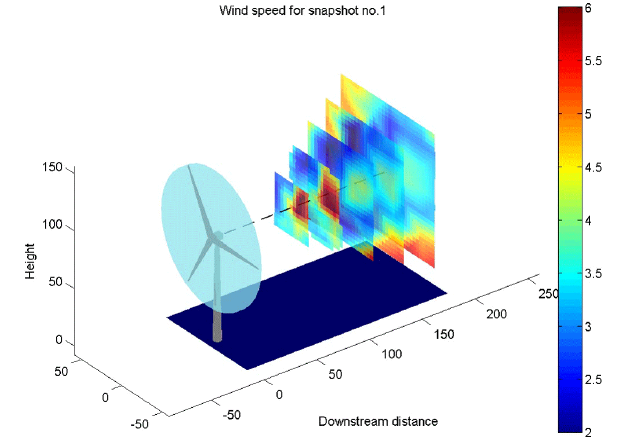
Figure 5. Example of snapshot taken with a nacelle-based lidar scanner. Measurement taken over ≈ 9s. The colour map represents the line-of-sight wind speed in [ms − 1 ] interpolated into a high- resolution